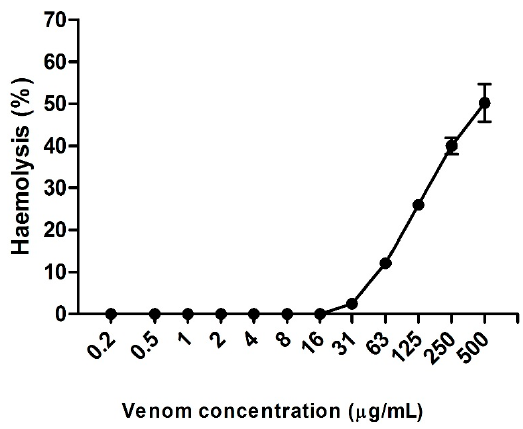
Figure 4. Percentage of hemolysis in different concentrations of Neoponera villosa venom.